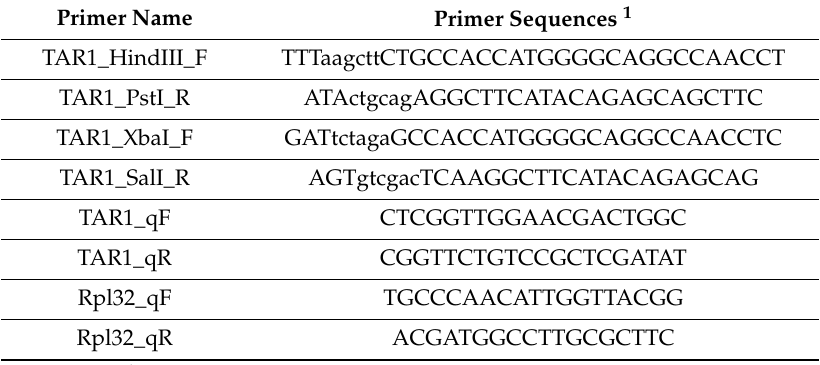
Table 1. Primers used for Pxtar1 gene clone and qPCR